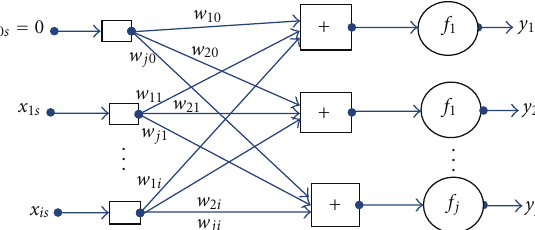
Figure 4: One-layer feedforward neural network combined to form the two-layer feedforward neural network of the SBLLM Scheme in Figure